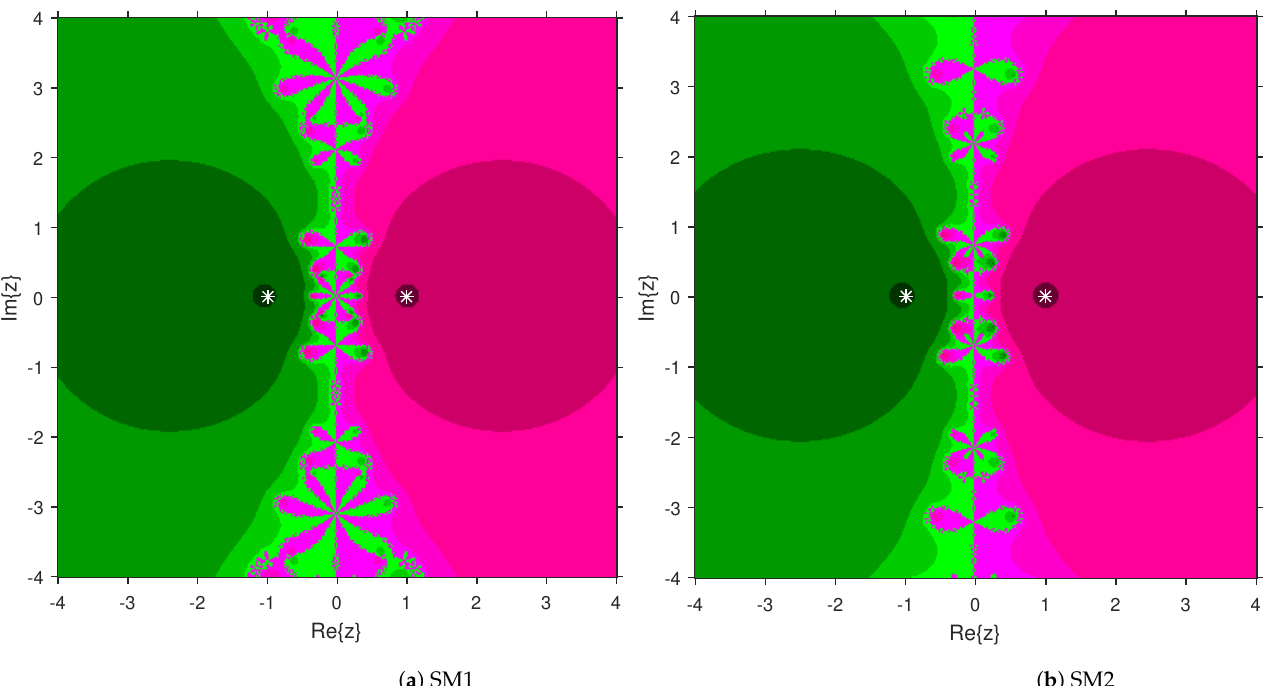
Figure 1. Attraction basins comparison between SM1 and SM2 related to M 1 ( z ) .